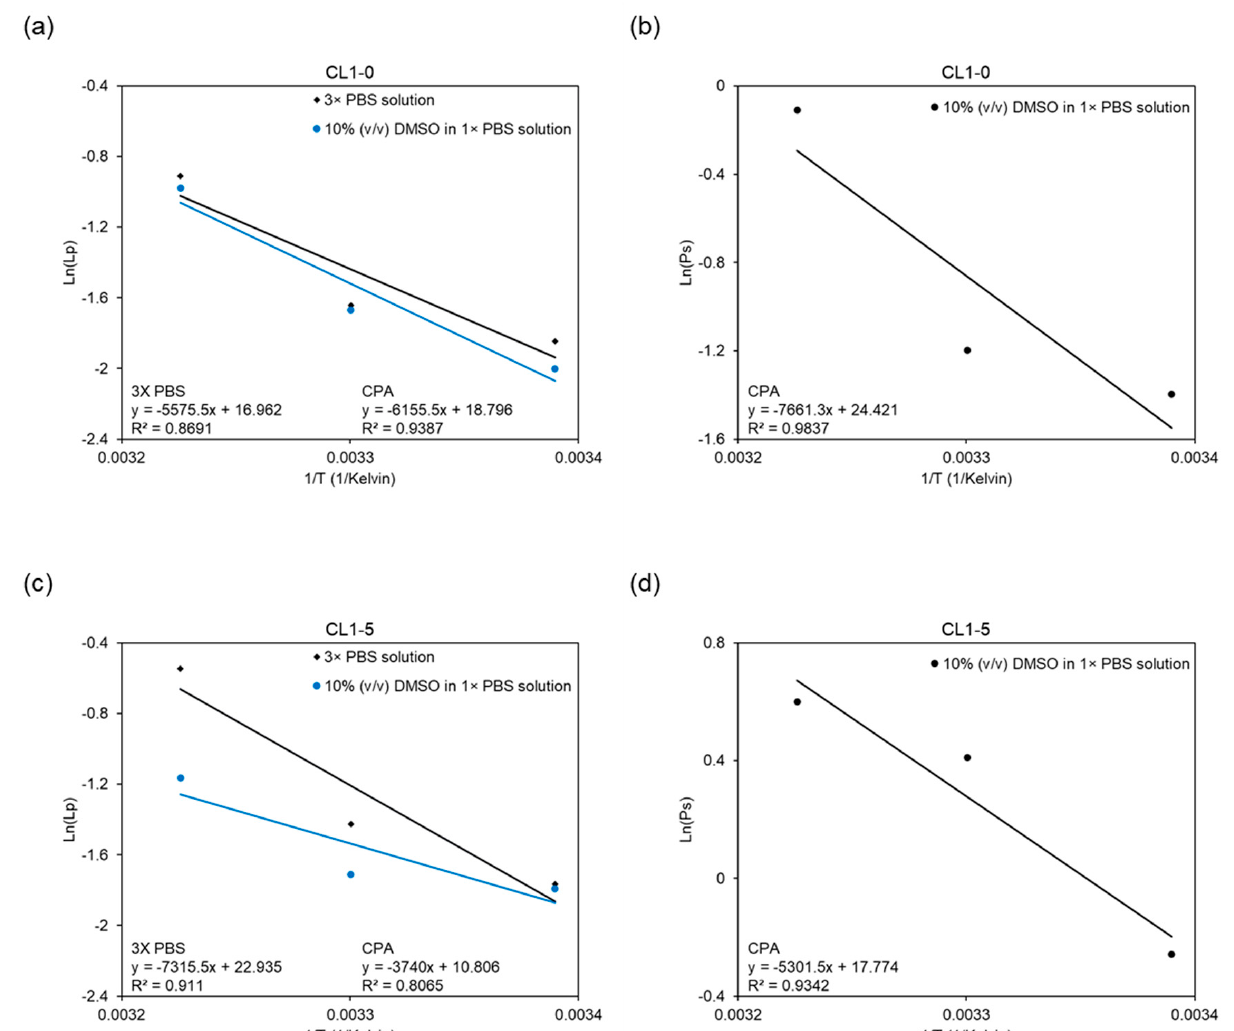
Figure 6. Arrhenius diagram showing the natural logarithms of the average membrane permeability of CL1-0 and CL1-5 versus the reciprocal of the absolute temperature for ( a ), ( c ) Lp in different hyperosmotic solutions, and for ( b ), ( d ) Ps in the ternary system.